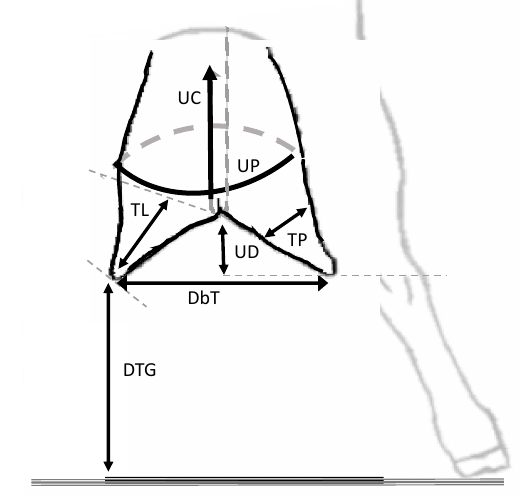
Figure 1. Udder physical conformation measurements. UP = Udder perimeter; TP = teat perimeter; DBT = distance between teats; TL = Teat length; UD = Udder depth; TDG = Teat distance to the ground; UC = Udder cleft .